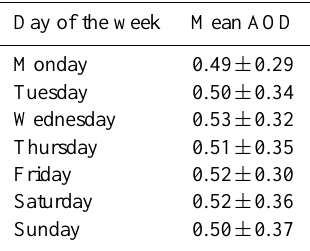
Table 3. Mean AOD values at 340nm and their standard deviations for each day of the